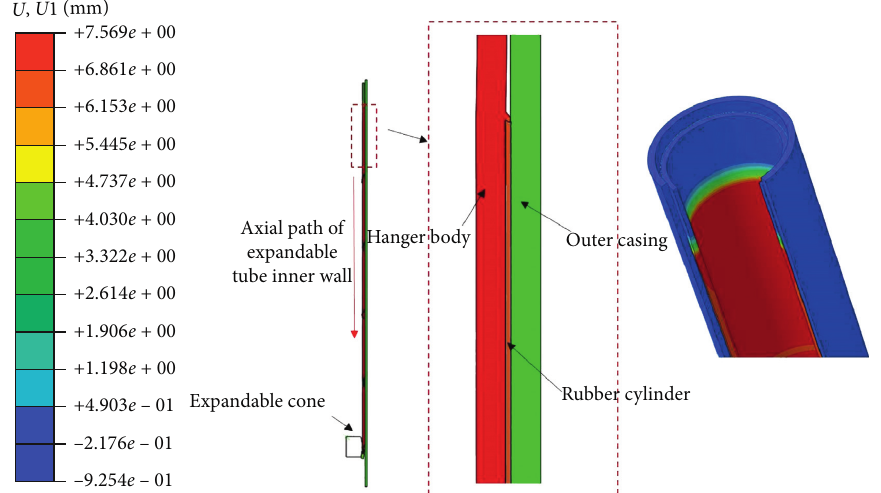
Figure 6: Radial displacement cloud diagram of the expandable liner hanger after expansion.